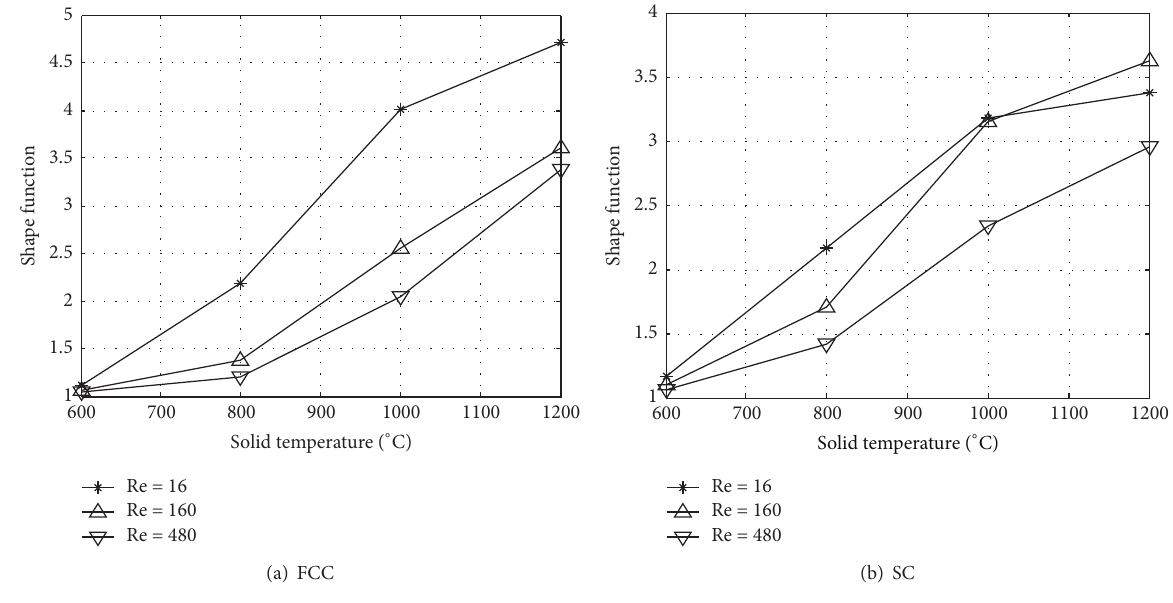
Figure 12: Shape function with different